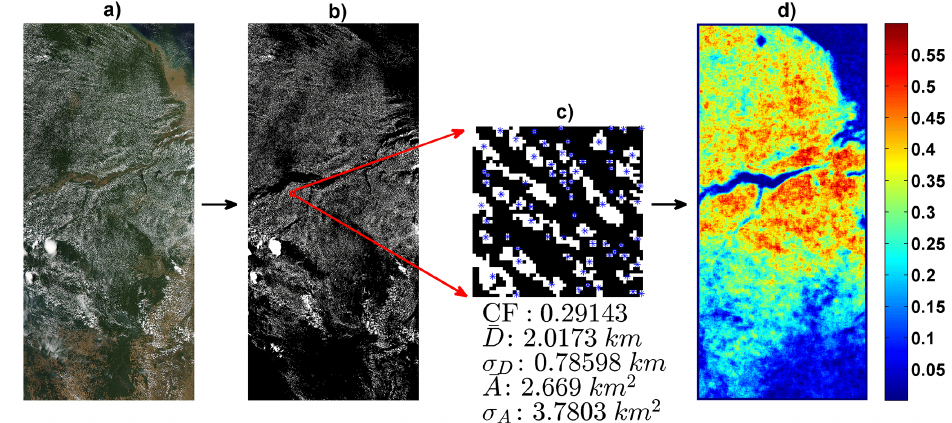
Figure 3. Summary of FCu field detection algorithm for 2011. (a) Corresponding true color geoTIFF image from Fig. 1. (b) Cloud mask of true color image; the red box represents a 25.5km × 25.5km moving window. (c) Close-up of the moving window. Blue asterisks indicate the centroids of individual clouds. Selected statistics of windows are listed below the panel. In this case the cloud field within the window passed the FCu field thresholds listed in Table 1. (d) Final product of algorithm, probability (0–1) of observing FCu field (pFCu) during J-A-S 2011. Table 1. Moving window thresholds for forest Cu (FCu), deep convective Cu, and sparse to no Cu cloud fields. Thresholds include cloud fraction (CF), mean cloud area ( A) , standard deviation of cloud areas ( σ A ) , mean distance between cloud centroids ( D) , and standard deviation of distances ( σ D ) . Missing data represent thresholds that are not relevant to the analysis. Parameter → CF [%] A [km 2 ] σ A [km 2 ] D [km] σ D [km] Field type